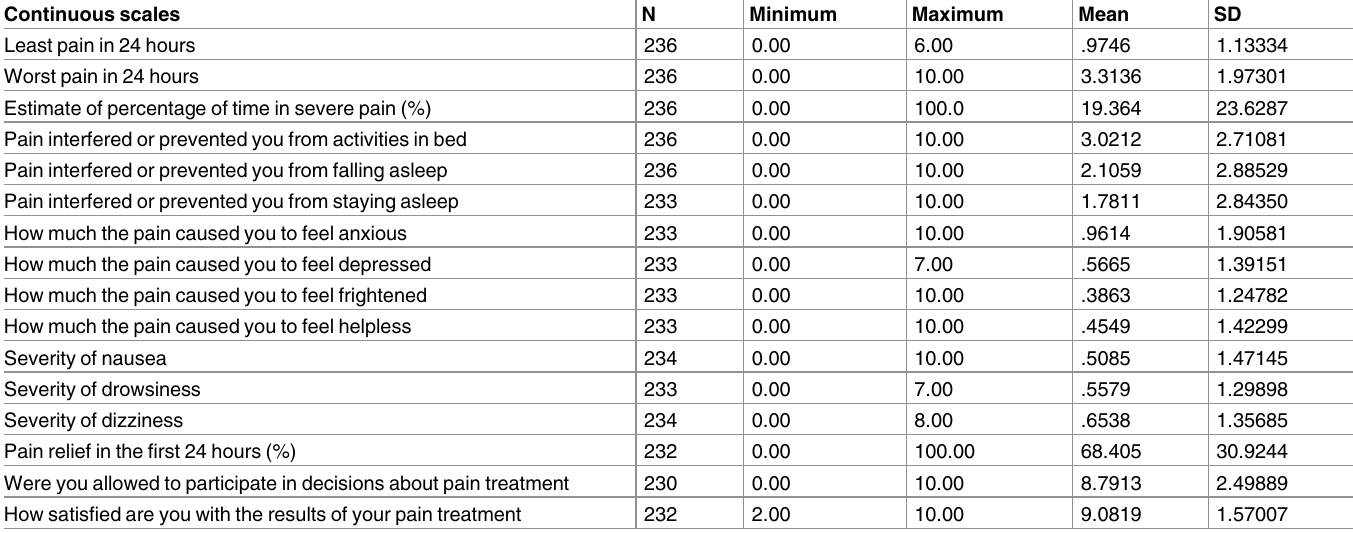
Table 7. Results of